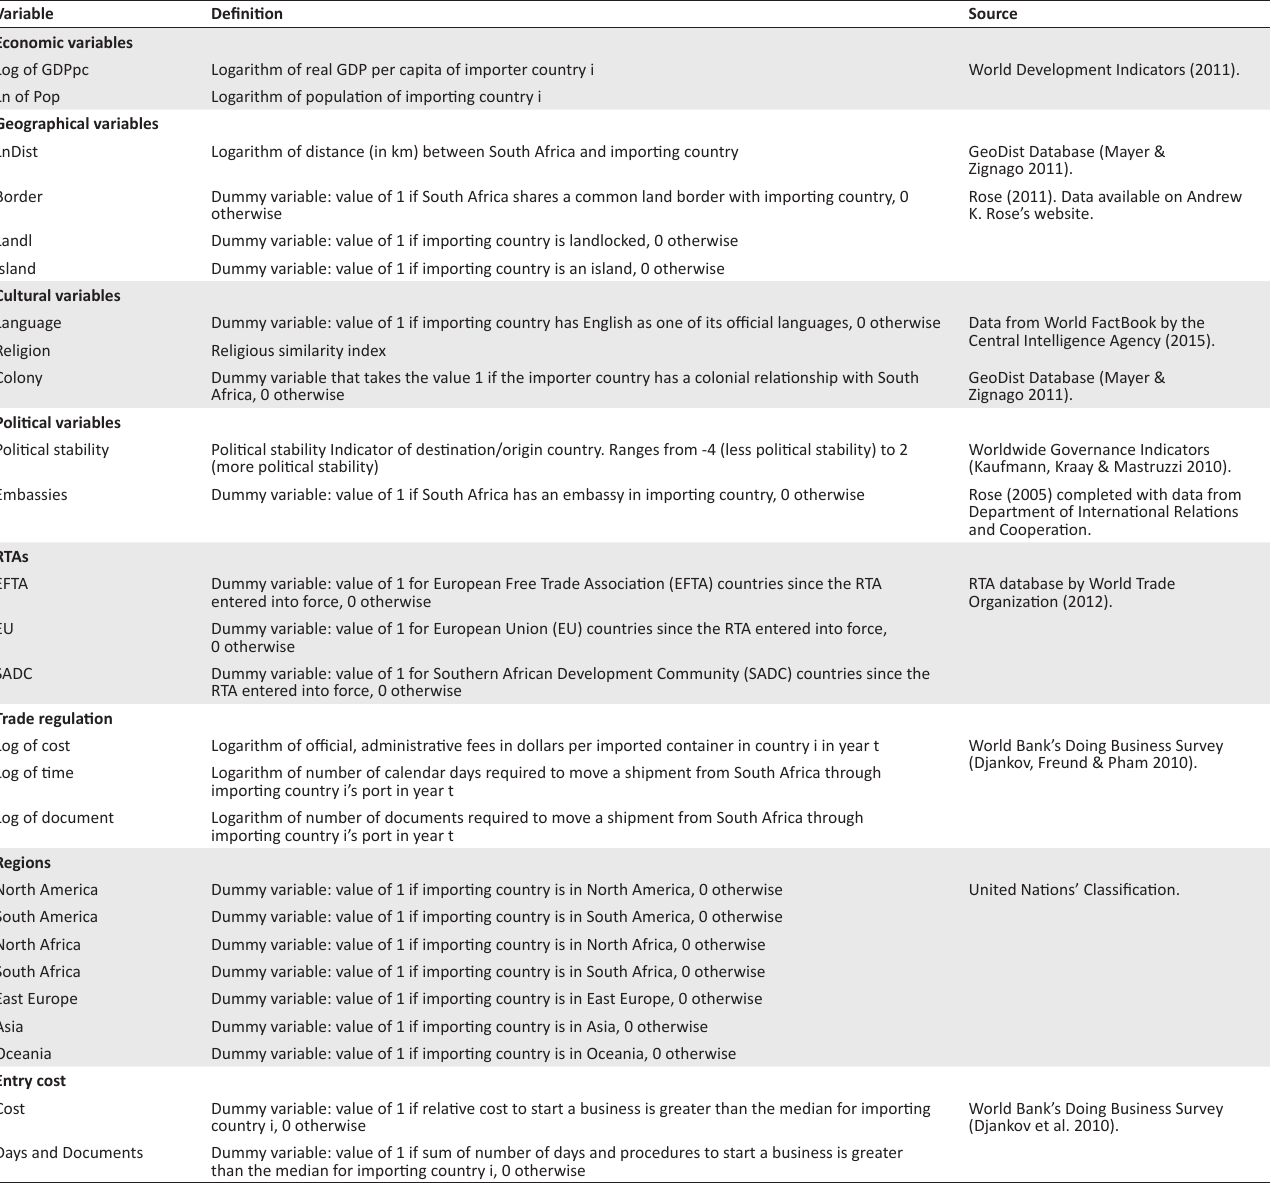
TABLE 3: Variable definitions and